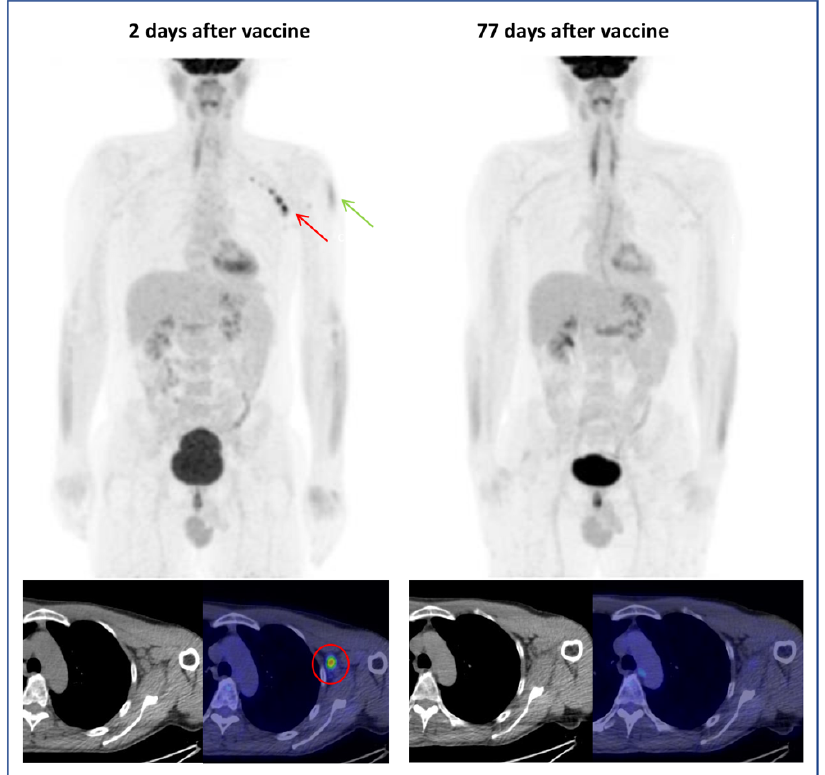
Figure 5. A 53-year-old man in follow-up for left supraclavicular melanoma (pT2aN0M0). [ 18 F]FDG PET/CT exam performed 2 days after vaccination showed axillary (SUVmax 9.1) and interpectoral (SUVmax 3.5) hypermetabolic lymphadenopathies (HLNs) (red arrow) and [ 18 F]FDG-uptake in left deltoid (injection site, green arrow). Being the HLNs ipsilateral to the site of the previous melanoma, a PET revaluation 77 days after vaccination was performed, showing the disappearance of FDG-avid lymphadenopathies in absence of therapy.